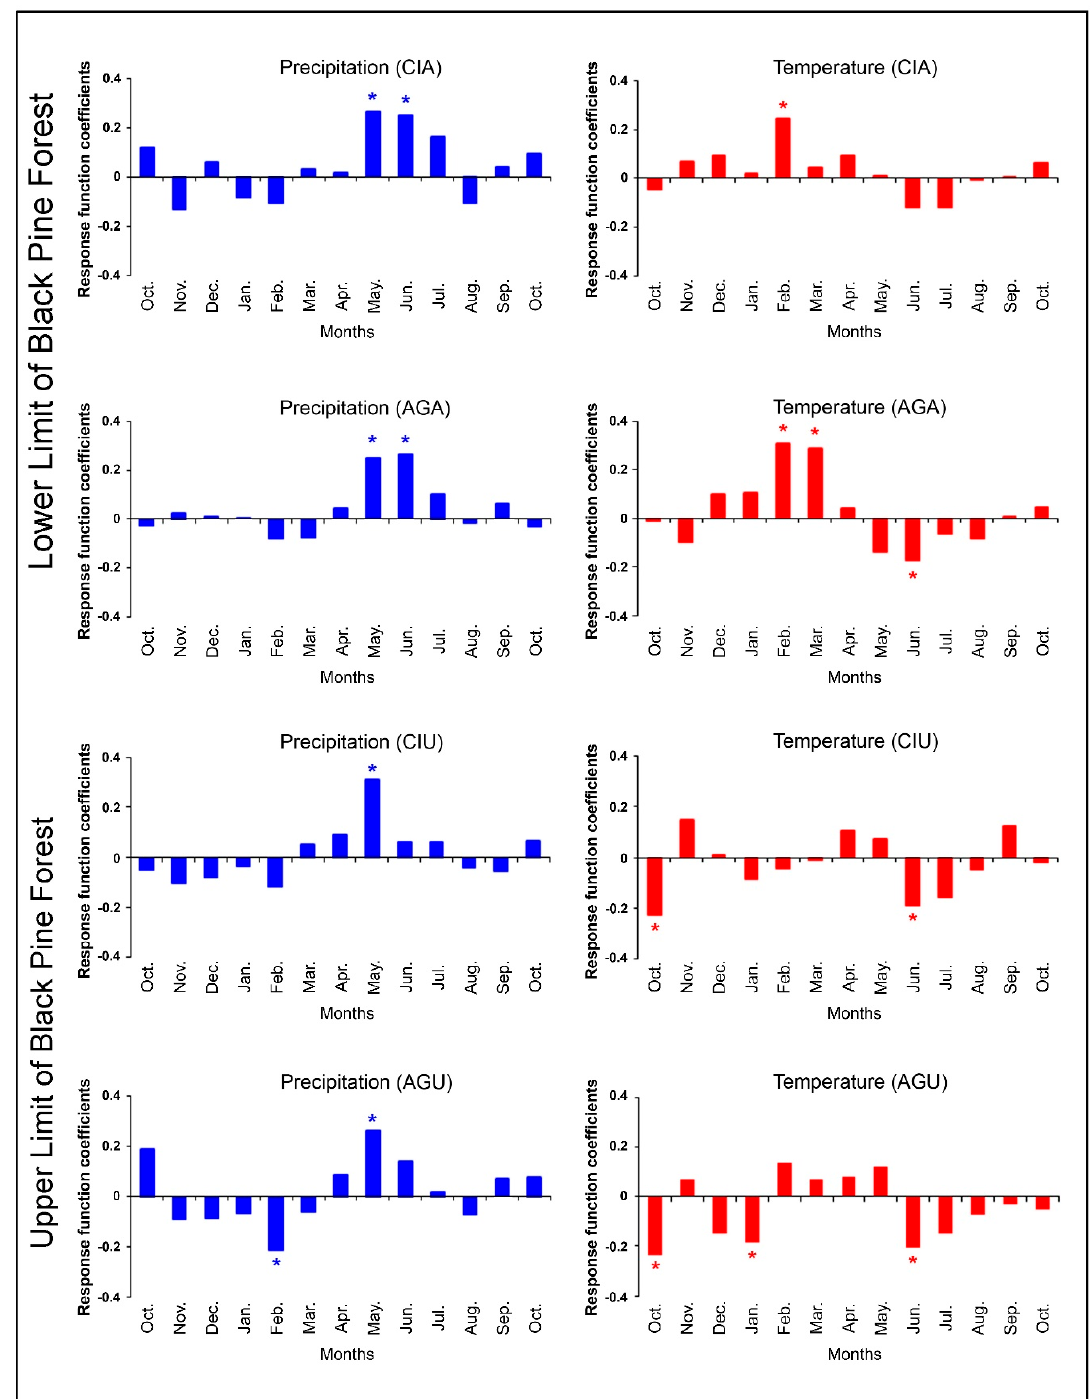
Figure 1. Mean response function coefficients of four site chronologies. Asterisks (*) represent significant correlation coefficient (95% level) with the related month.